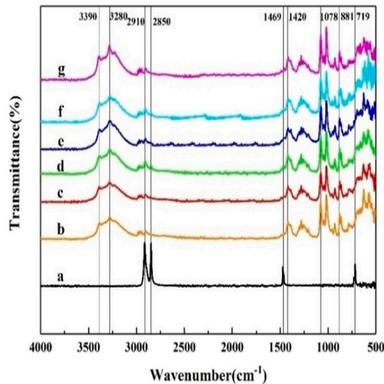
FT-IR spectra of (a) HDPE, (b) DM, (c) PCM2, (d) PCM3, (e) CPCM1,